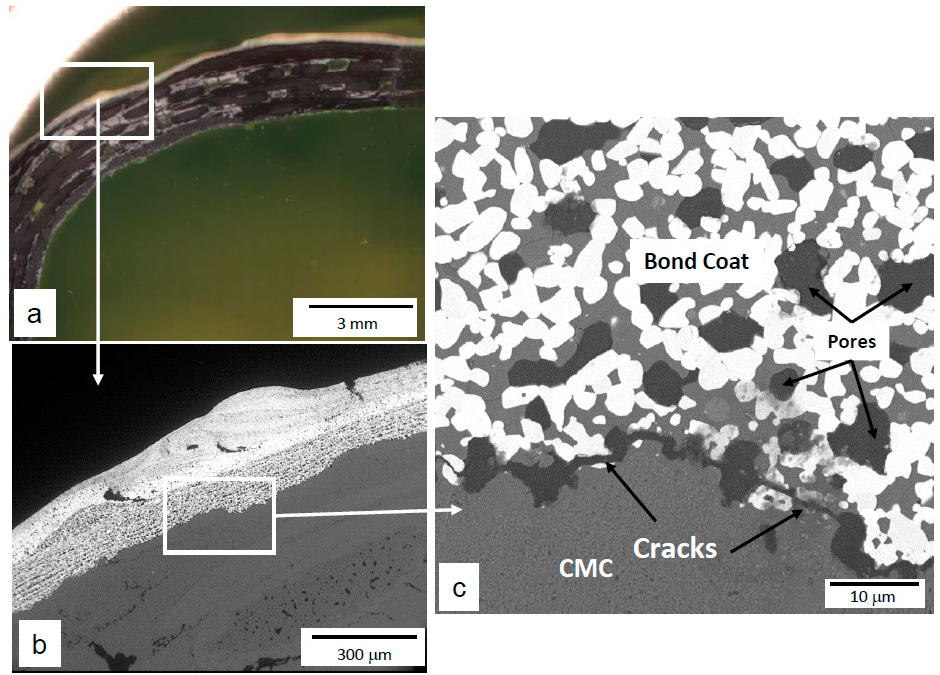
Figure 10. ( a – c ) are, with increasing magnification, the cross-section of an area between the leading edge and the flat surface. A high magnification view ( c ) shows cracks developing along the bond coat/CMC interface.